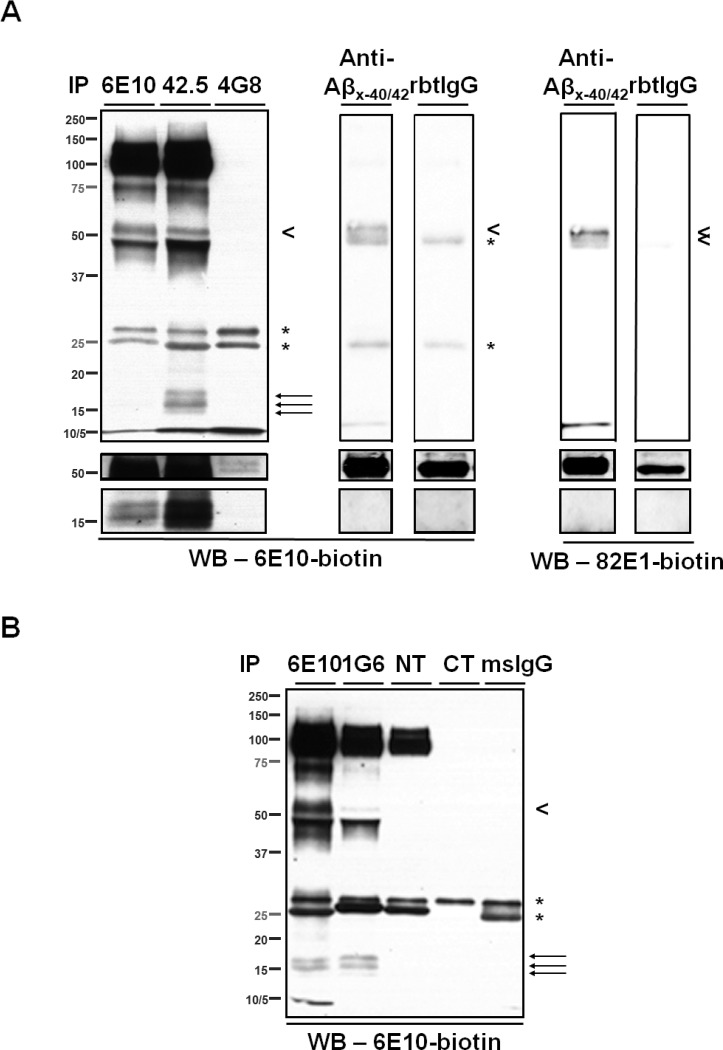
Immunological characterization of the ~55- and the ~15- kDa, 6E10-immunoreactive proteins in CSF.(A) A series of antibodies directed against various epitopes of Aβ were used to immunoprecipitate target proteins from CSF, and blots were probed with biotinylated- 6E10 or 82E1. Capture antibodies are indicated by the labels above each lane. Top panels show short exposure (30 sec), and bottom panels show longer exposure (3 min). Note that the ~55-kDa proteins (arrowheads) were immunoprecipitated by monoclonal antibodies targeting the N-terminal region (6E10 and 42–5), mid-region (4G8) and the C-terminal end of Aβ (anti-Aβx-40/42); whereas the ~15-kDa proteins (arrows) were only immunoprecipitated by monoclonal antibodies targeting the N-terminal region of Aβ. (B) A series of antibodies directed against various epitopes of APP were used to immunoprecipitate target proteins from CSF, and blots were probed with biotinylated 6E10. Capture antibodies are indicated by the labels above each lane. Both the ~55- and the ~15- kDa species were immunoprecipitated by monoclonal antibody 1G6 directed against an APP epitope N-terminally adjacent to Aβ, but not by antibodies directed against the N- (“NT”) or C- (“CT”) termini of APP. Mouse and rabbit IgGs (msIgG, rbtIgG) served as negative control capture reagents. * = non-specific bands.